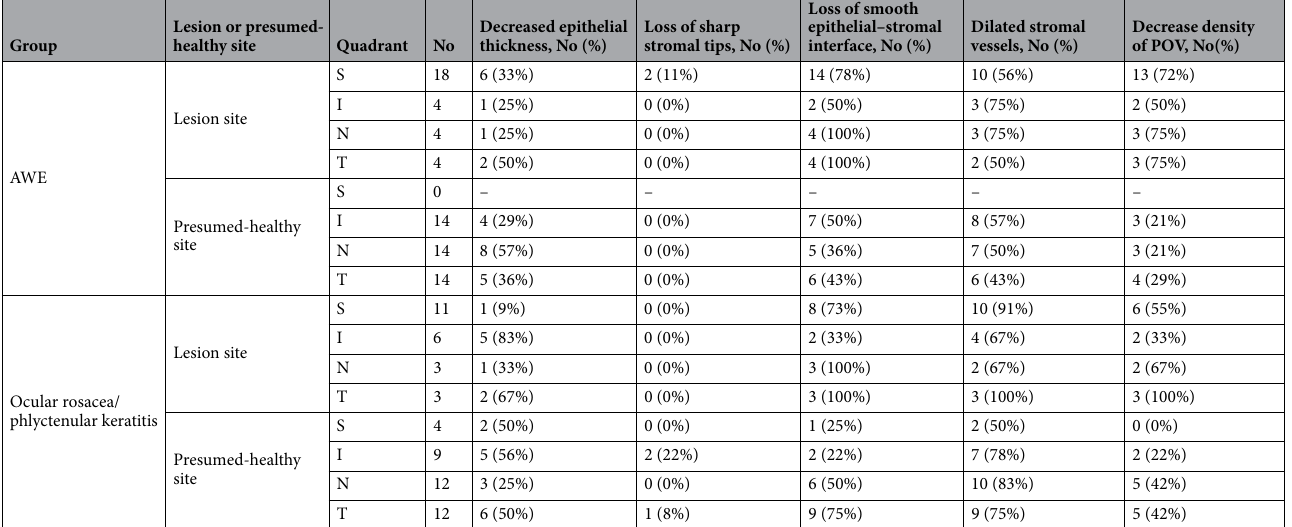
Table 4. Percentage of different abnormal POV patterns in the four quadrants in diseased eyes detected through SD-OCT. No case number, S superior limbus, I inferior limbus, N nasal limbus, T temporal